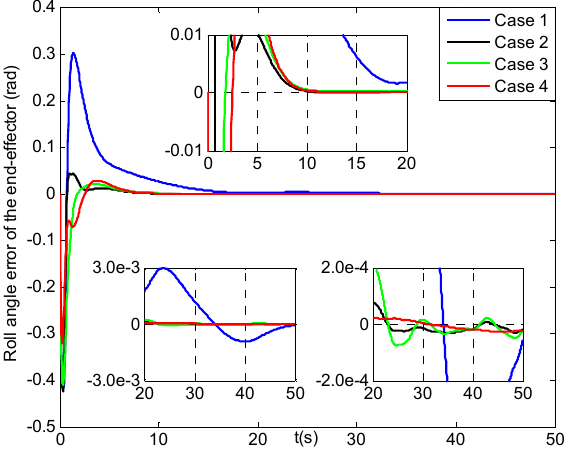
Figure 15. Roll angle errors of the end − effector (4 cases).